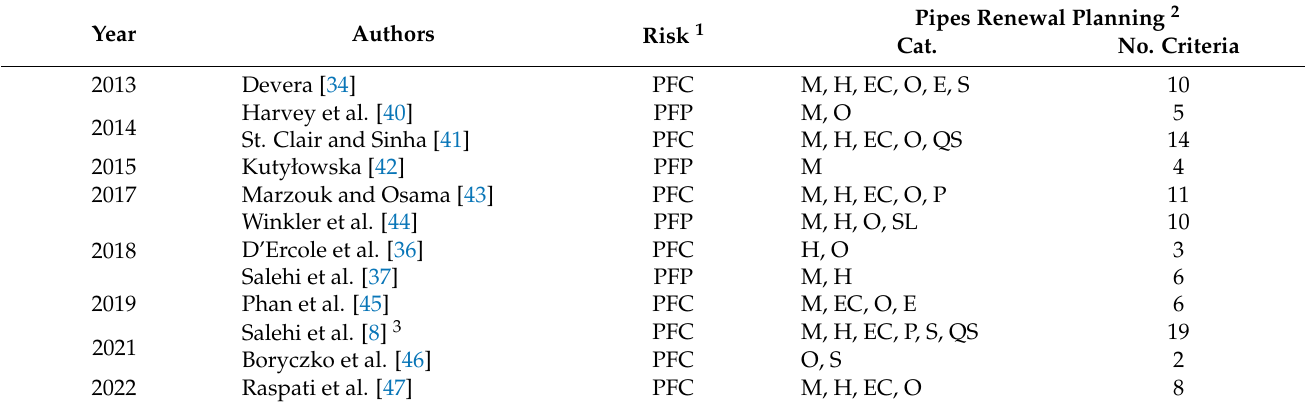
Table 1. Some recent studies (2013–2022), categorization (Cat.), and the number of criteria effective in pipe renewal